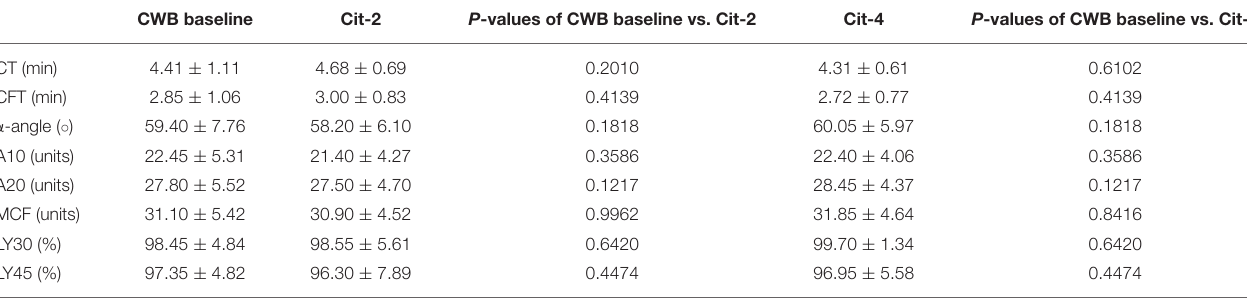
TABLE 2 | Results of CWB baseline compared to CWB rested for 2h (Cit-2) and 4h (Cit-4).